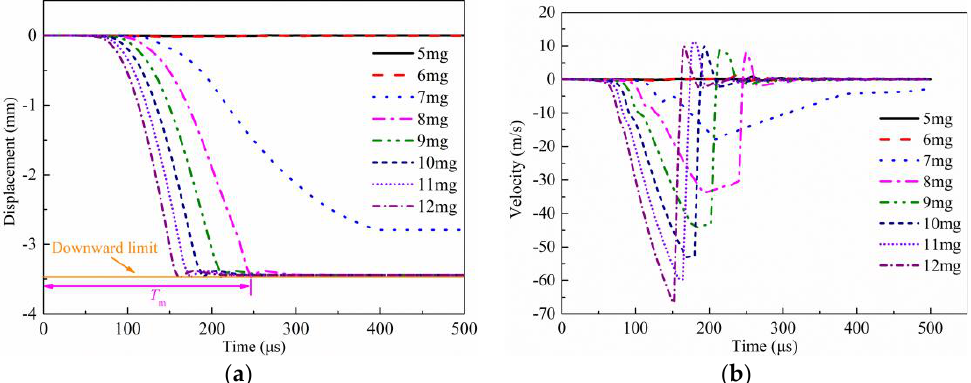
Figure 11. Dynamic simulation results: ( a ) displacement–time history curve, ( b ) velocity–time history curve.